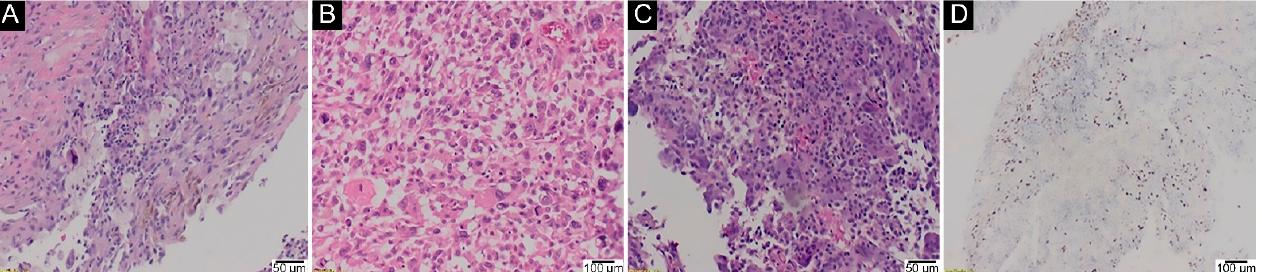
Figure 6. Secondary malignant GCTB developed in a 38-year-old male after 14 years of irradiation of primary tumour. ( A , B ) overt sarcomatous atypia (H&E, 100× and 40×, respectively); ( C ) small foci of a more typical GCTB histology (H&E, 40×); ( D ) anti-histone 3.3 G34W positive nuclear stain (IHC, 100×). p.Gly35Trp mutation was confirmed via molecular analysis.